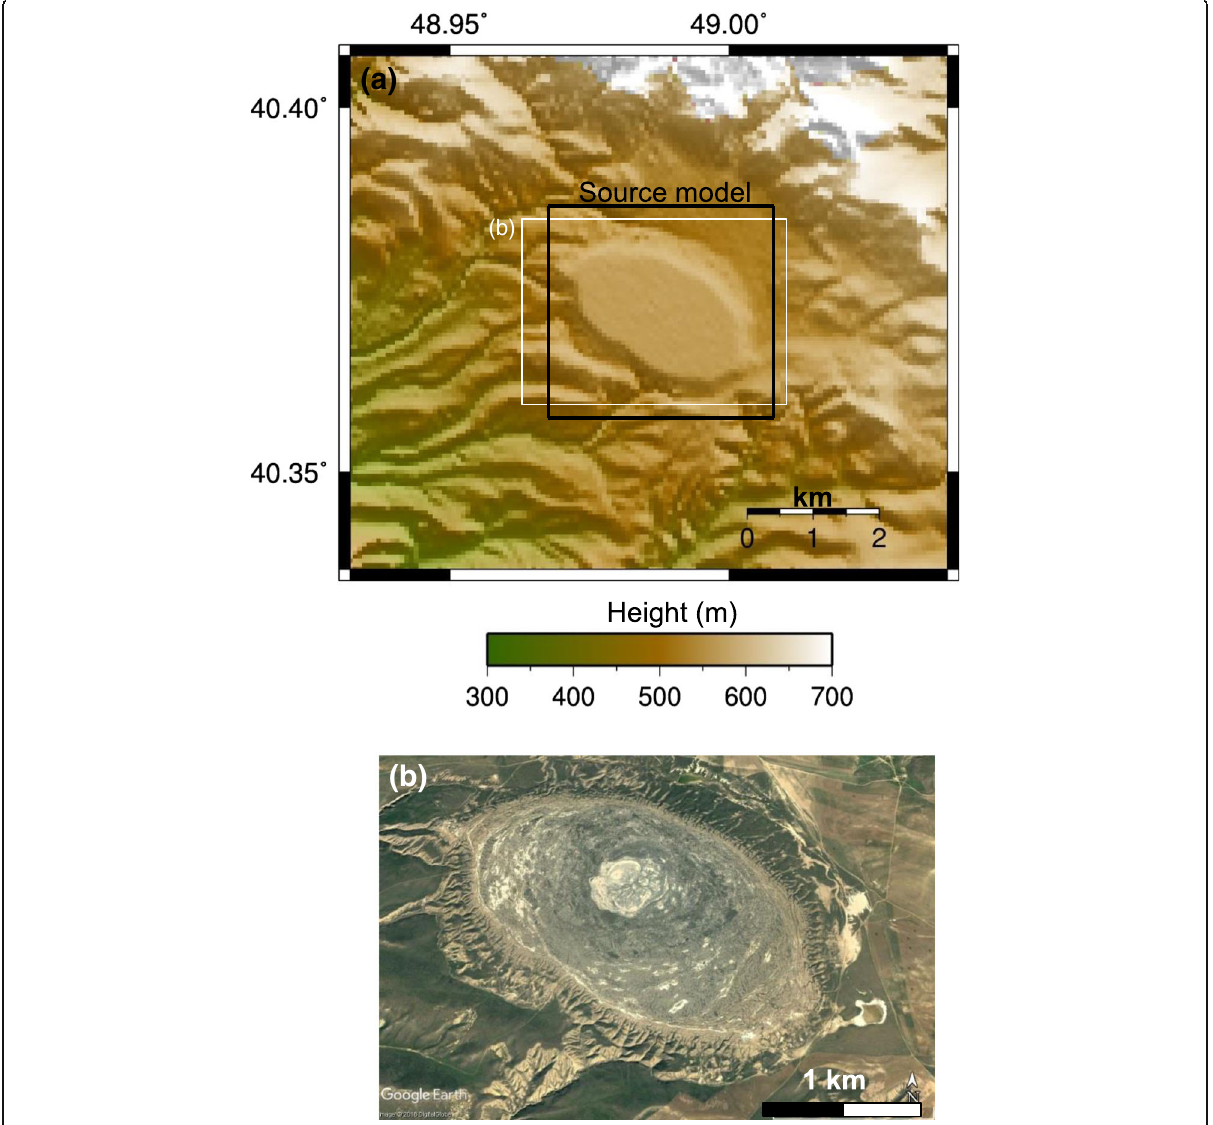
Fig. 2 a Elevation map of Ayaz-Akhtarma mud volcano and its surrounding area based on the ALOS World 3D-30 m (AW3D30) DEM. Plan view of the source model in Figs. 12 and 13 is also indicated with black line. b Google Earth image of Ayaz-Akhtarma mud volcano, acquired on 24 March